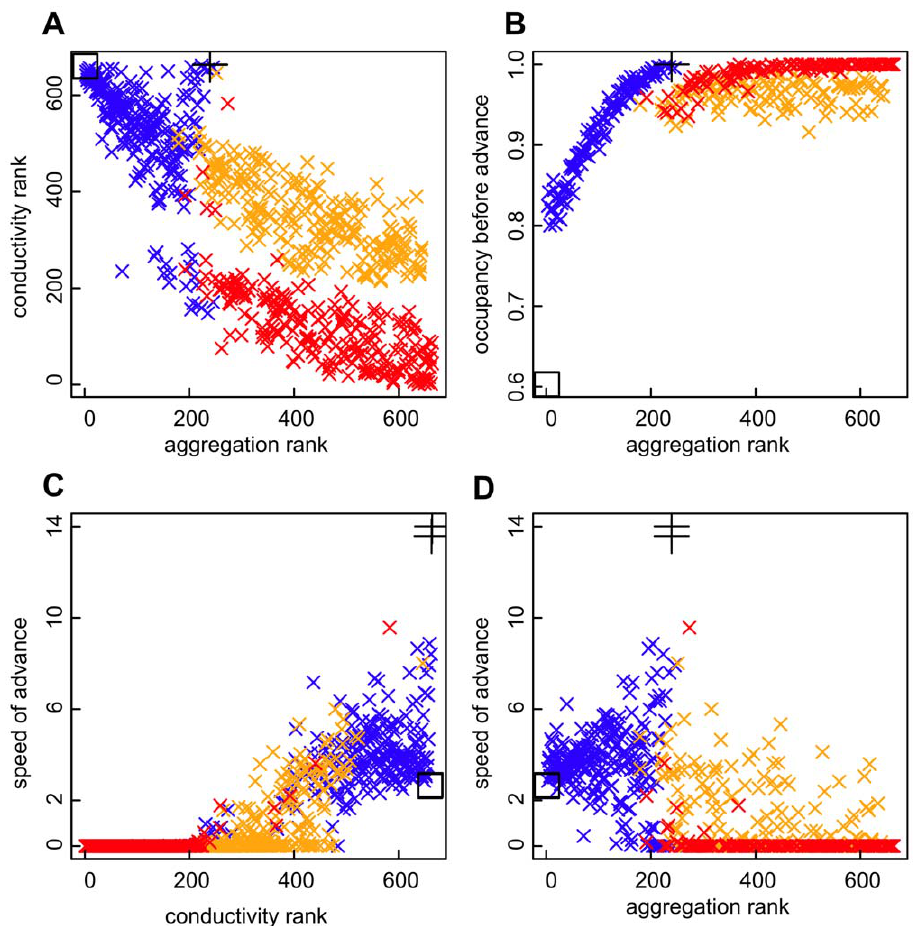
Figure 3. The trade-off between conductivity (good for speed of advance) and aggregation (good for steady-state occupancy). ( a ) Rank correlation between landscape metrics of conductivity and aggregation. Red points are from patchy landscapes, blue from channeled landscapes and orange from patchy landscapes with stepping stones. Aggregation increases with fractal dimension within each family of landscape (cf fig. 1). Large black cross represents the cross landscape and square represents the regular landscape. ( b ) The occupancy of landscapes in simulations before range advance started, at the end of the 200 time-step ‘‘burn-in’’, against aggregation with symbols as in ( a ). ( c–d ) The speed of advance into the unoccupied landscape in cells per time step, against the conductivity ( c ) and aggregation ( d ) metrics, with symbols as in ( a ). Each point represents one simulation run. Metapopulation parameters were a mean dispersal distance of 8 cells, fecundity of 100 (propagules produced by an occupied cell) and per-cell extinction rate of 0.2.